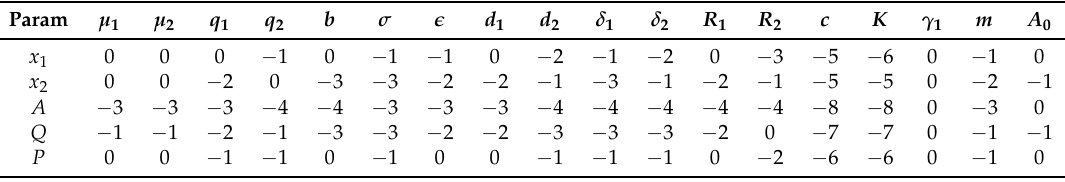
Table 1. Order of sensitivity. The number represents the maximum order of sensitivity of a variable with respect to a parameter. For instance, at the intersection of µ 1 and x 1 , 0 means changing µ 1 by 1% will affect at most a change of order 0 in x 1 . In this table, 0 corresponds to most sensitive and − 8 means least sensitive. The most insensitive parameters with combined order less than − 10 are c , K , δ 1 , and δ 2 . Thus, we fix them in the new model. Note that d 2 also has a combined order of sensitivity less than − 10; however, since d 1 is sensitive, we do not fix d 2 . Also, we do not carry out the sensitivity for γ 2 , since we fix it as 0 for the new model, due to its small range.